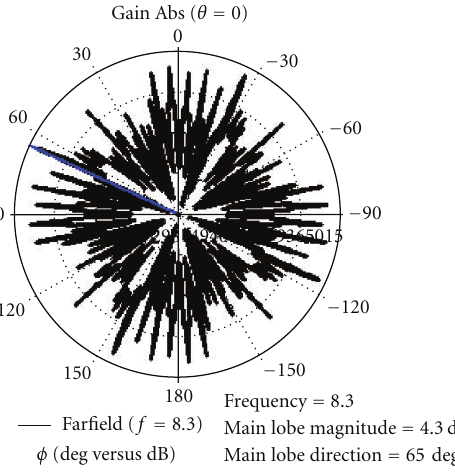
Figure 11: Gain plot at 8.3 GHz (phi/degree versus dB).